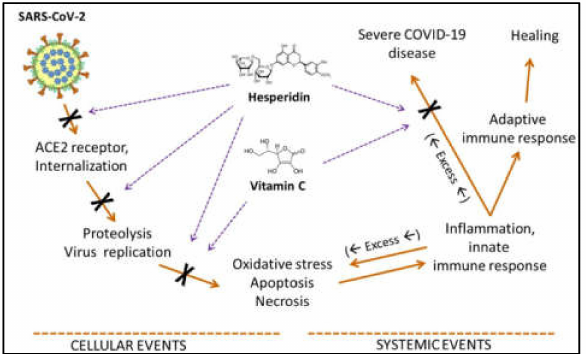
Figure 7. Multiple effects of hesperidin (coupled with ascorbic acid) on SARS-CoV-2 entry and replication, and systemic inflammation. Creative Commons Attribution (CC BY) license from Bellavite and Donzelli